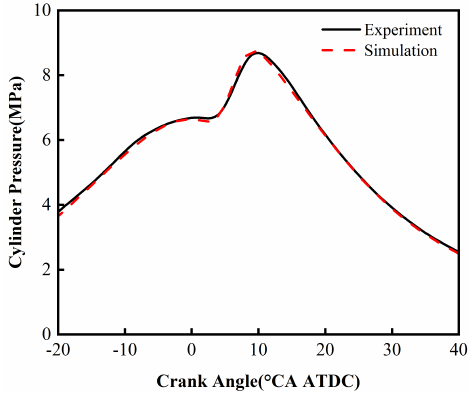
Fig. 2 Model verification.